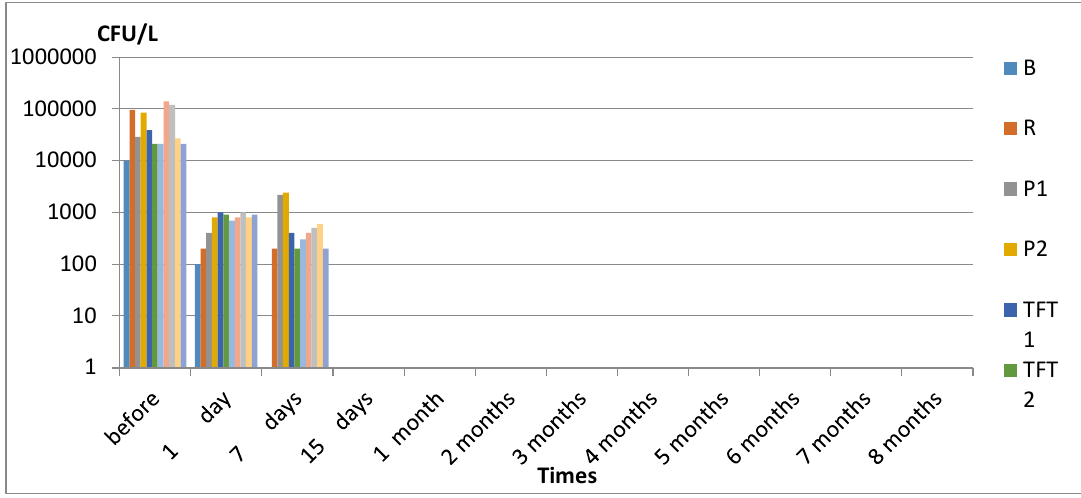
Figure 2. Legionella pneumophila sg1 counts at all the sampling points during the whole period of the study in Hospital 2. (B = boiler; R = recirculation; P1 = point 1; P2 = point 2; TFT1 = time flow tap 1; TFT2 = time flow tap 2; TFT3 = time flow tap 3; TFT4 = time flow tap 4).